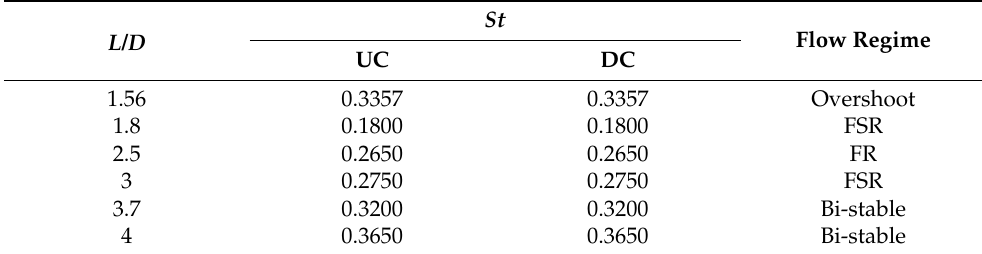
Table 4. Summary of the St values and different flow regimes.